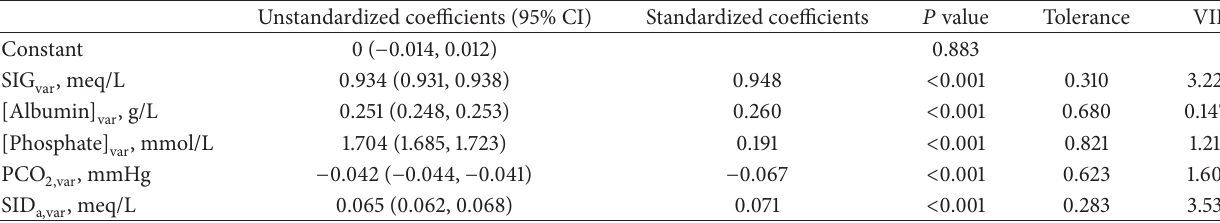
Table 3: Output of the multiple linear regression model correlating AG var (dependent variable) with SIG var , [ Albumin ] , and SID a , var (independent variables) (adjusted 𝑅 2 = 0.9999 , 𝐹 = 201890.24 , and 𝑃 < 0.001 PCO 2, var